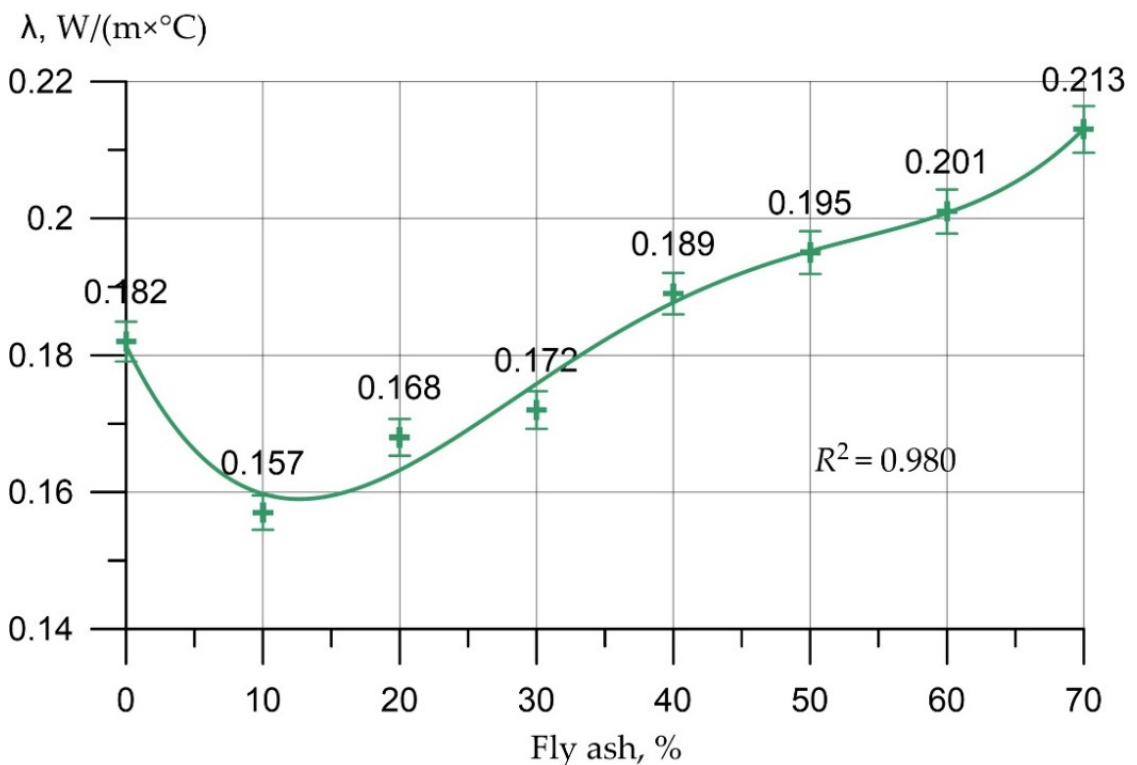
Figure 8. Dependence of the TC of FFC samples on the amount of FA.